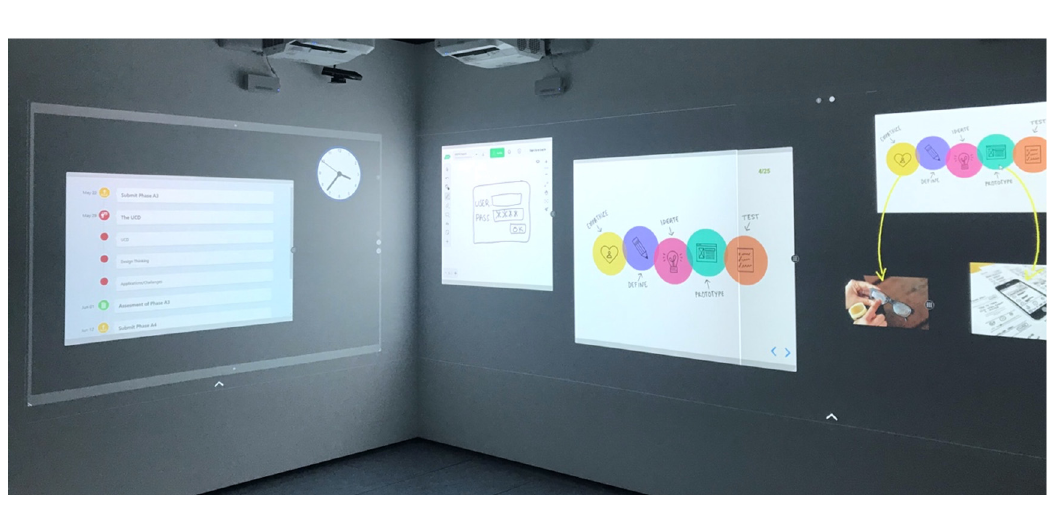
Figure 4. A snapshot of CognitOS Board.